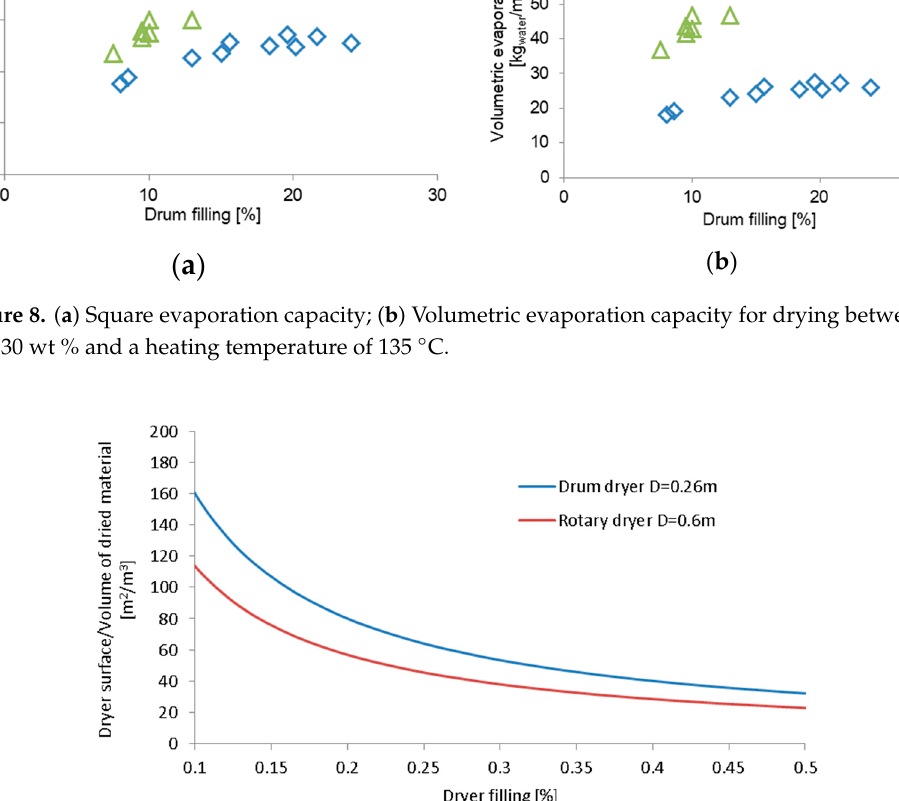
Figure 8. (a) Square evaporation capacity; (b) Volumetric evaporation capacity for drying between 50 and 30 wt % and a heating temperature of 135 °C.